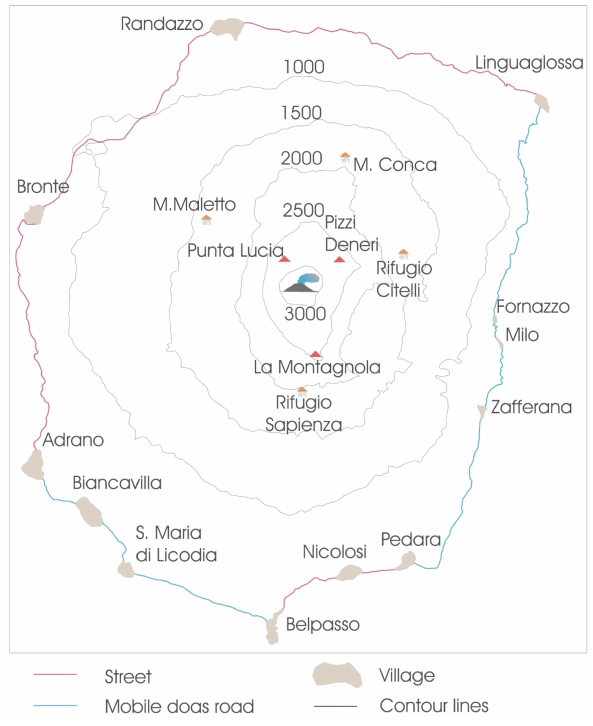
Fig. 1. Map of Mt. Etna. The small houses (Rifugio Sapienza, Rifu- gio Citelli, Mt. Maletto and Mt. Conca) indicate the measurements sites of the Mini-MAX-DOAS measurements at a distance of about 6km from the source. The main routes for the SO 2 traverses during 2006 are indicated by blue lines; in red are the rarely used